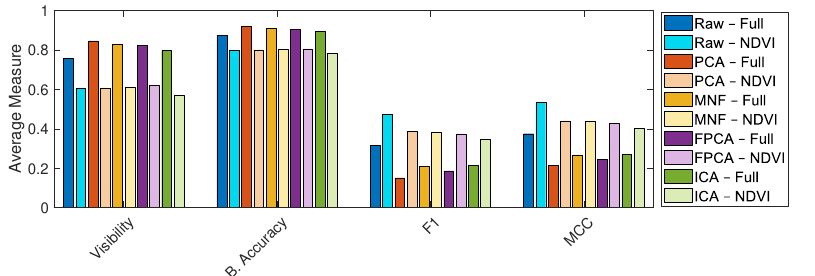
Figure 13. Comparison between the performance measures when combining spatial and spectral DR on the OP7 dataset.